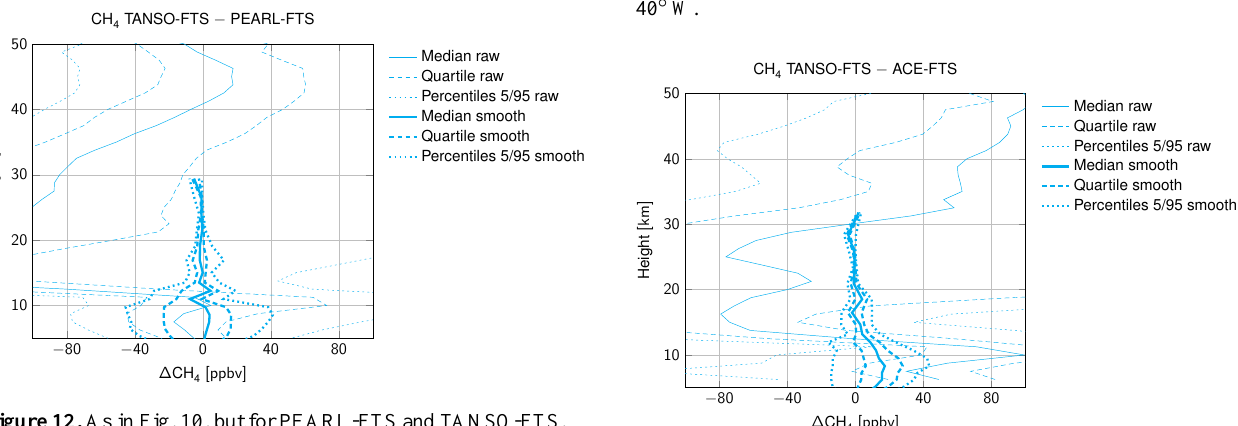
Figure 12. As in Fig. 10, but for PEARL-FTS and TANSO-FTS.